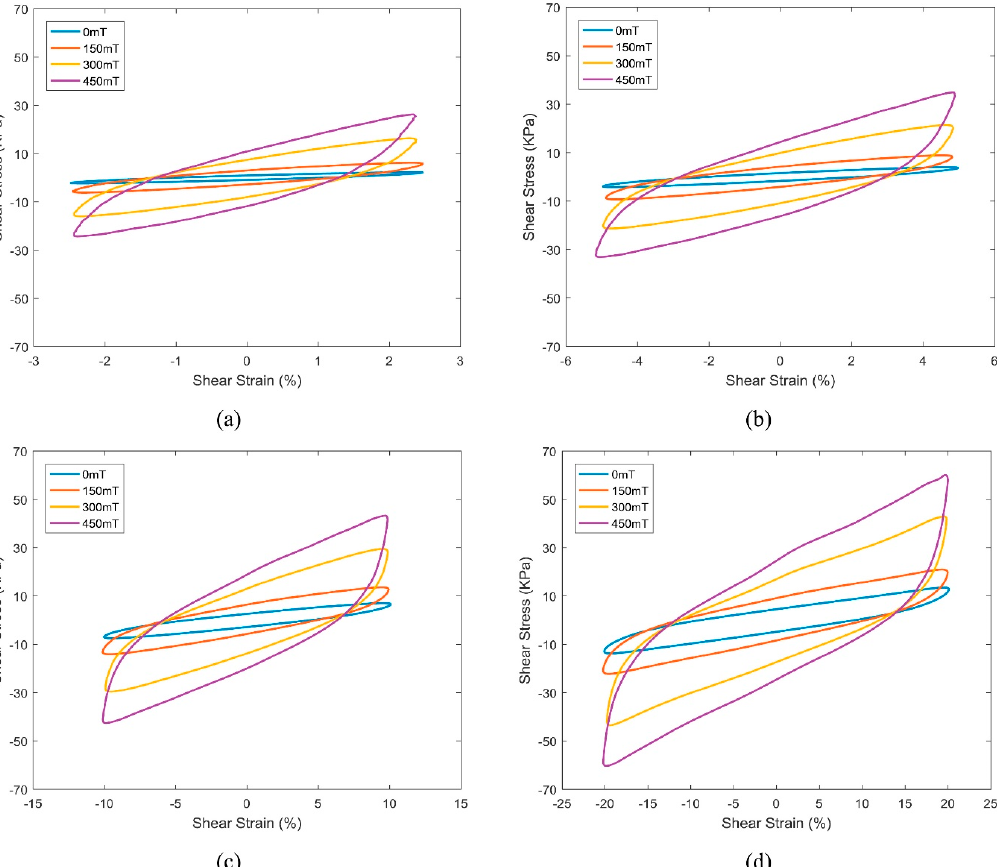
Figure 17. Effect of magnetic flux density on the measured stress-strain hysteresis loops of the MRE as a function of different strain amplitude at 10Hz: ( a ) 2.5%; ( b ) 5%; ( c ) 10%; and ( d ) 20%. Reprinted from [24], © 2019 with permission from Elsevier.